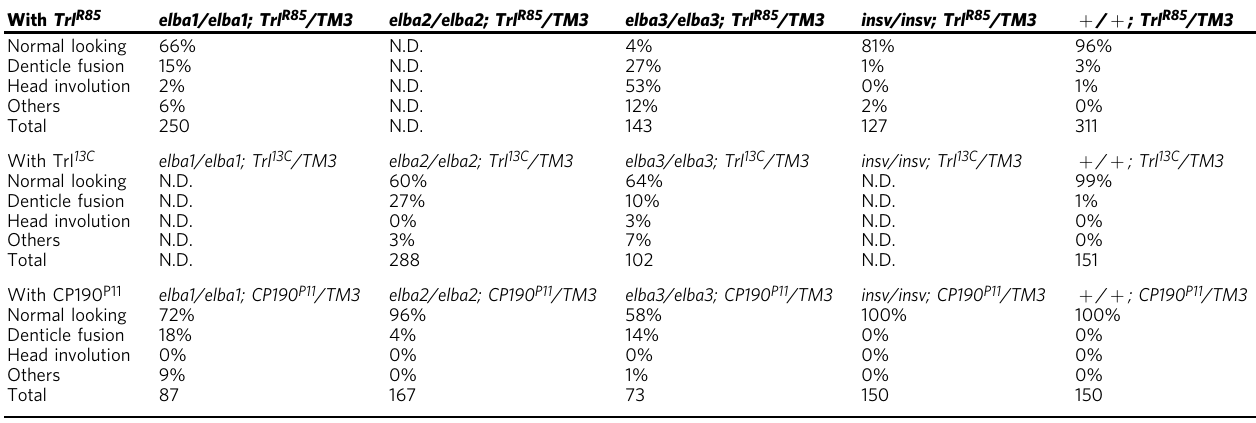
Table 1 Genetic interactions between ELBA and Insv with Trl (GAF) or